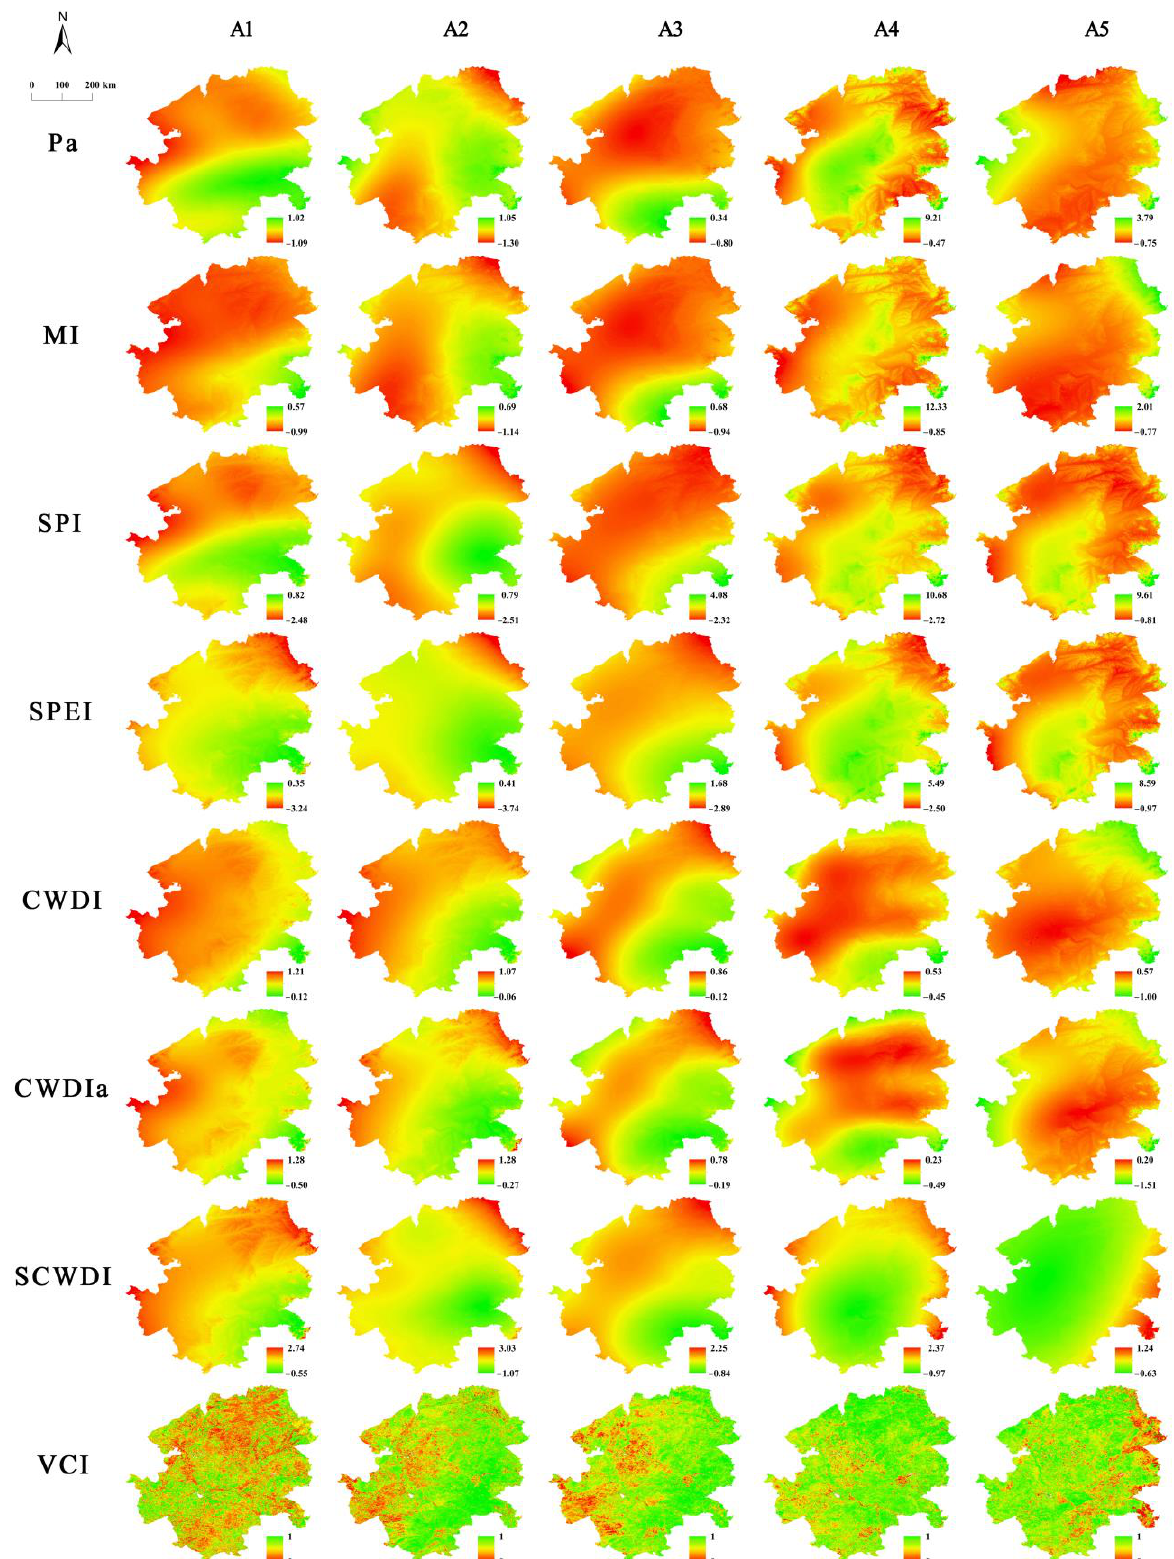
Figure 4. Comparison of different drought indexes in space.